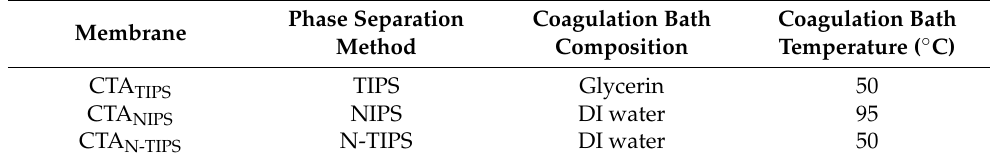
Table 1. Preparation conditions of different substrate membranes. Membrane